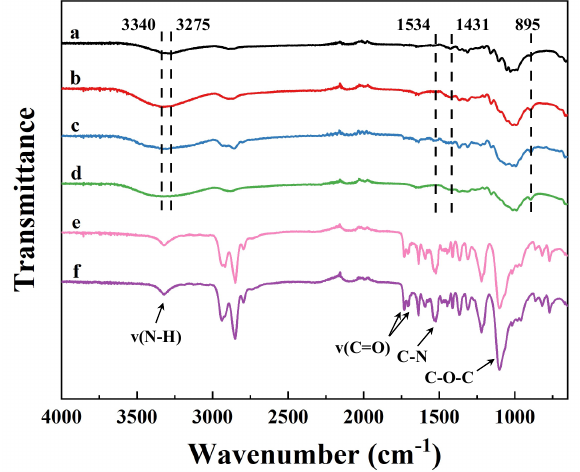
Figure 3. FT-IR spectra of ( a ) cotton–elastane fabrics, ( b ) HRC, ( c ) NRC, ( d ) DRC, and undissolved components separated from ( e ) H 2 SO 4 solvent system and ( f ) NaOH/urea solvent system.